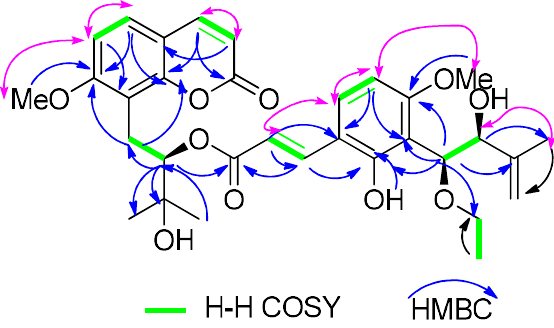
Figure 2. Key 1 H- 1 H COSY and HMBC of new compound ( 1 ).